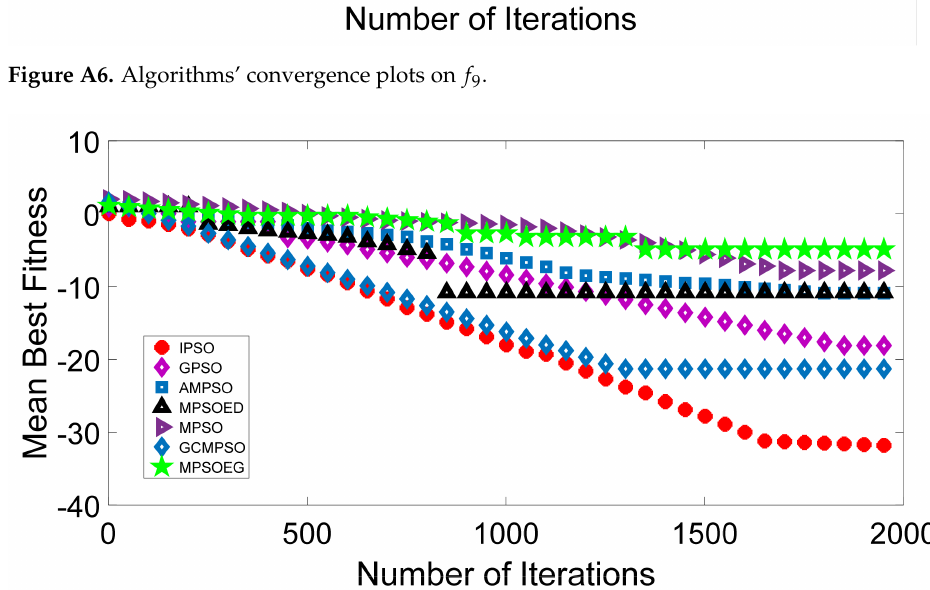
Figure A7. Algorithms’ convergence plots on f 10